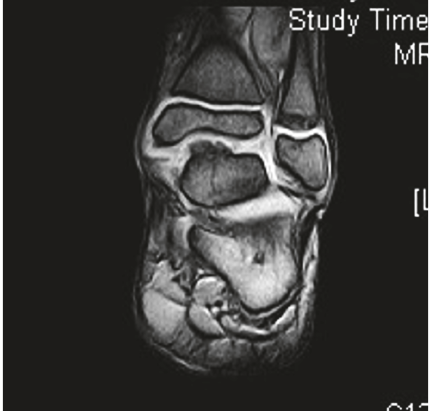
Figure 3: MRI view of the